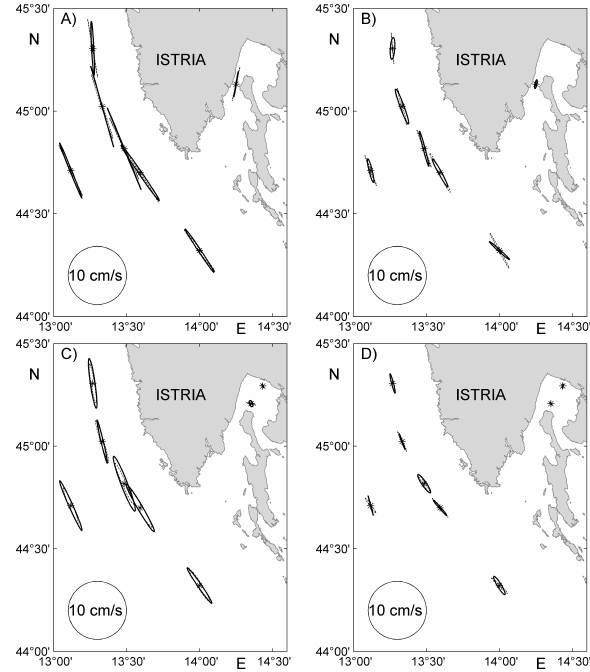
Fig. 11. Tidal ellipses for the M2: (A) surface, (C) bottom and K1: (B) surface, (D) bottom tidal constituents, based on observations (bold solid) and model results